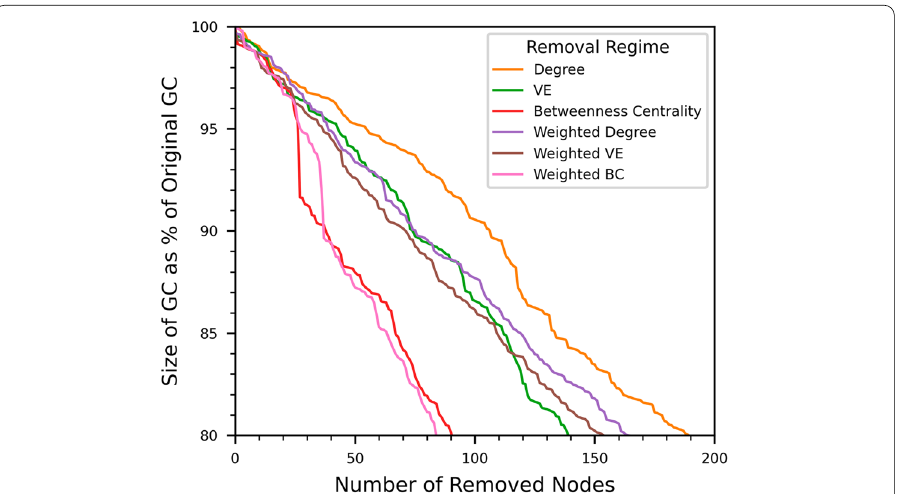
Fig. 4 The reduction in the size of the giant component of the airline route graph as the number of removed nodes increases under targeted node removal strategies. Note that the removed node count does not include disconnected nodes. The rate of GC dismantling is fastest for Weighted Betweenness Centrality and slowest for degree. Weighted degree and both forms of Vertex Entropy show similar behaviour with the GC reducing marginally more quickly for unweighted Vertex